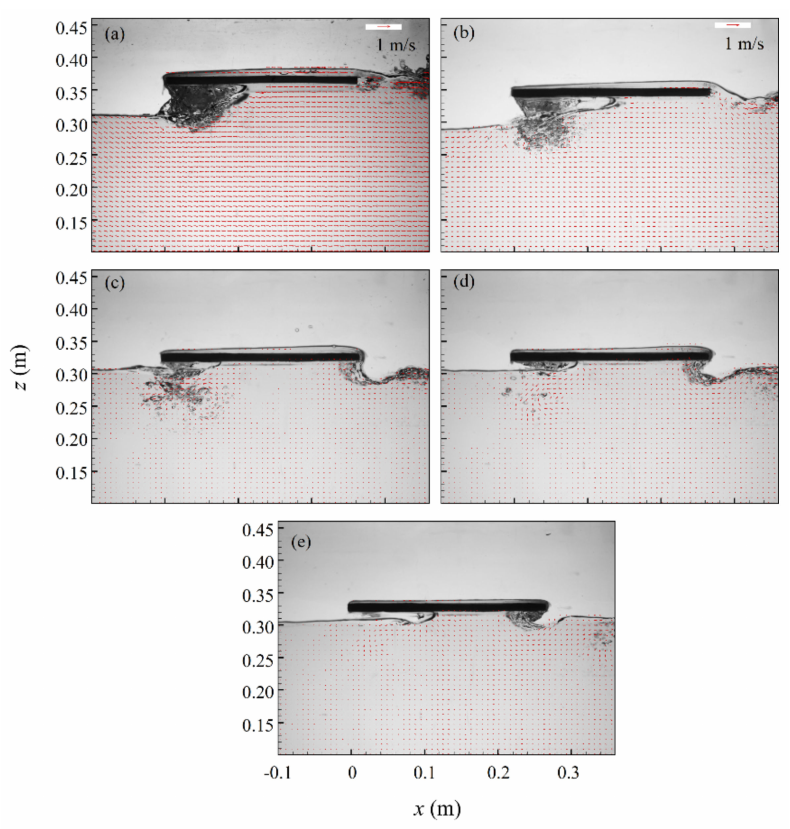
Figure 9. Same with Figure 7 for T = 1.03 (Phase C): ( a ) case 1, D / h = 6/30, H / h = 10/30; ( b ) case 2, D / h = 4/30, H / h = 10/30; ( c ) case 3, D / h = 2/30, H / h = 10/30; ( d ) case 4, D / h = 2/30, H / h = 8/30; and ( e ) case 5, D / h = 2/30, H / h = 6/30.